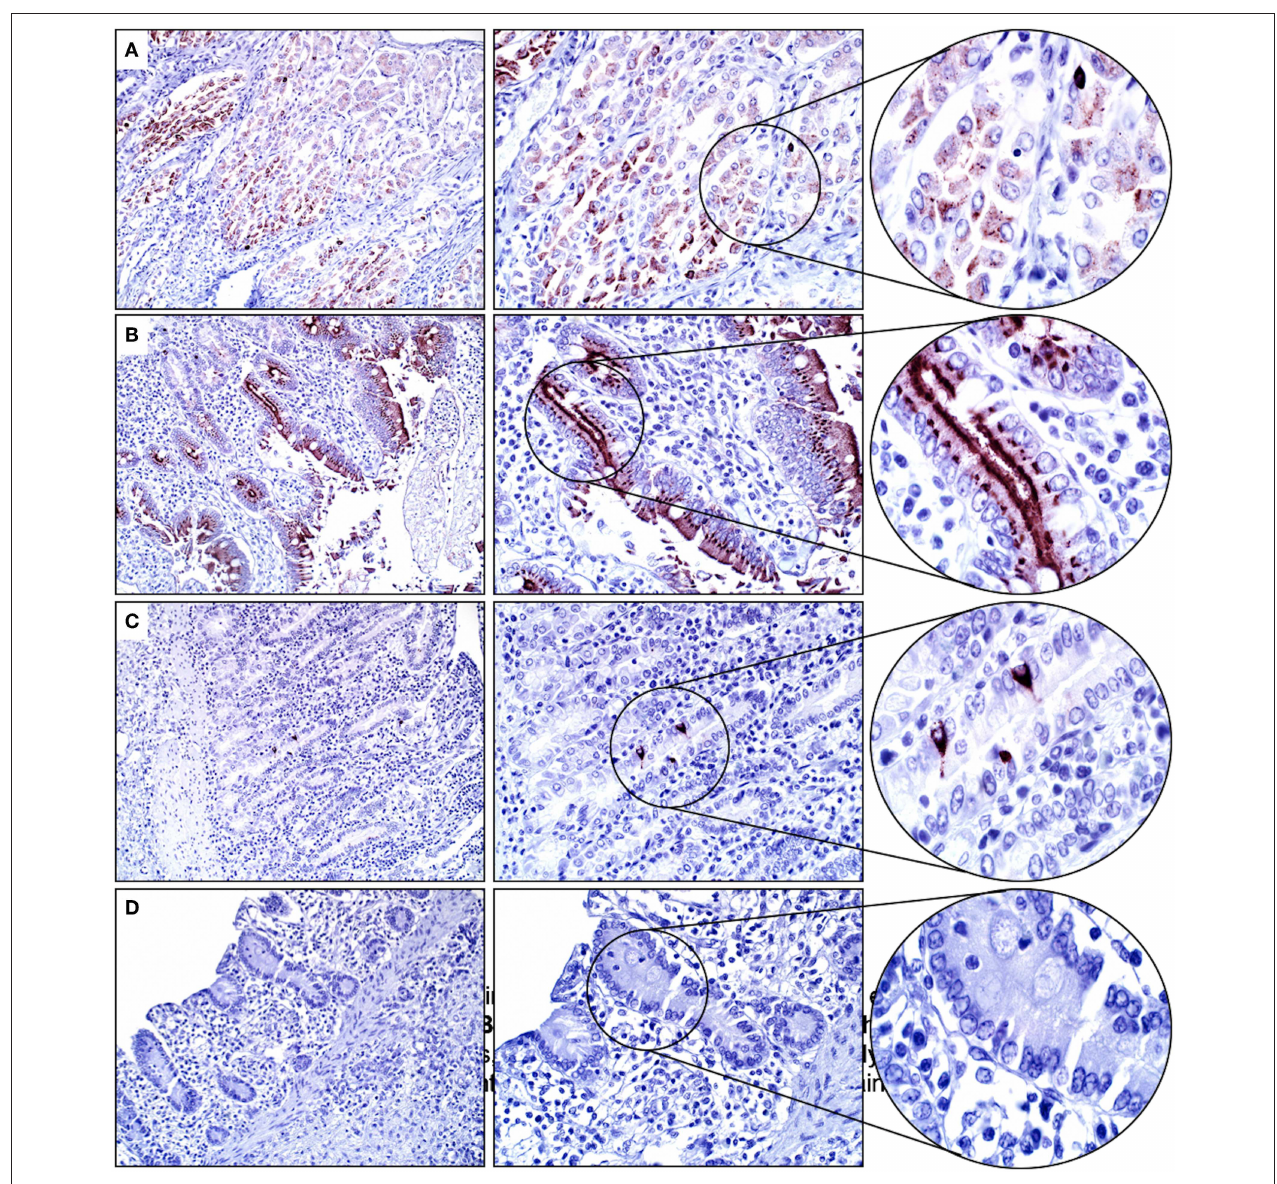
FIGURE 3 | Glandular stomach and intestinal tract. (A) Gastric mucosal epithelial cells are moderately SALSA positive. (B) In the duodenum the surface epithelium, and in particular the apical aspect of cells, stains intensively positive. (C) Only rare individual epithelial cells in the distal small intestine have strong cytoplasmic staining. (D) No SALSA immunoreactivity is detected in the large intestine. Magnification as in Figure 2 .